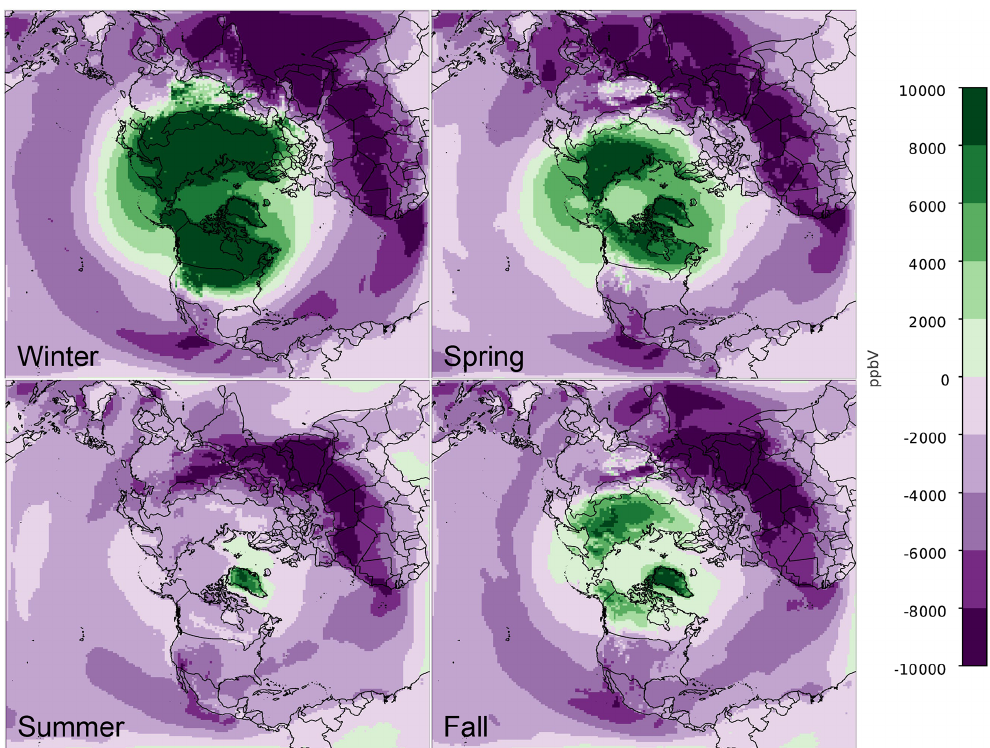
Figure 10. Difference in seasonal average surface O 3 mixing ratios (ppbv; all hours) between HCMAQ521 and HCMAQ531_M3Dry sim- ulations (HCMAQ531_M3Dry – HCMAQ521). Green shading indicates higher O 3 mixing ratios and purple shading indicates lower O 3 mixing ratios in the HCMAQ531_M3Dry